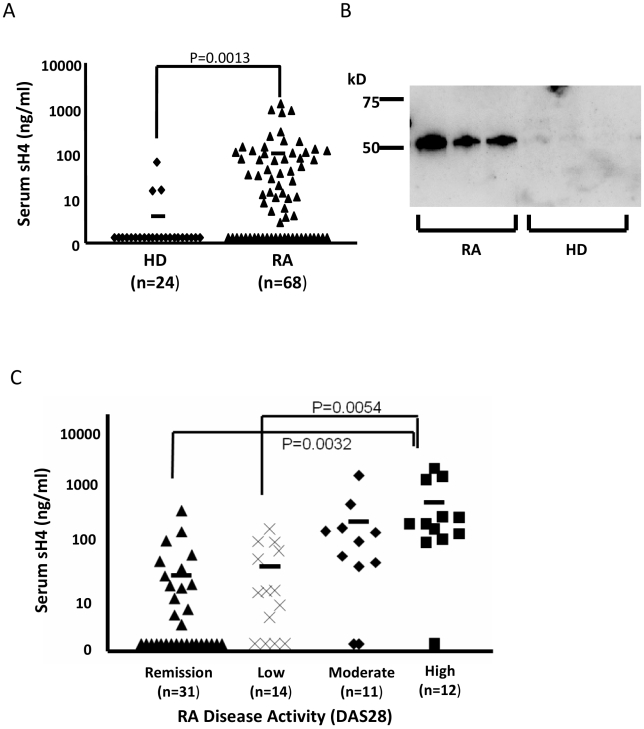
Detection of sH4 in sera from RA patients.(A) The concentration of the sH4 in HDs and in the patients diagnosed with RA. Sera from 68 RA patients and 24 HDs were diluted 1∶10 in PBS and tested by ELISA as described in Materials and Methods. The data were analyzed by the Mann-Whitney U test followed by a multiple regression analysis (p<0.01). (B) The sH4 in sera of RA patients was detected by Western blotting using HRP-labeled anti-human B7-H4 mAb (clone hH4.3). A 50 kDa sH4 band was detected in the sera of three patients with RA but not in the sera from three HDs. (C) The correlation of serum sH4 levels and disease severity in the patients with RA. Patients with RA were classified into four severity groups based on DAS28 score described in the Materials and Methods. The concentration of sH4 in the serum of each patient was determined by ELISA as described above. Statistical analysis was performed by ANOVA method followed by the Scheffé test. The bars represent the mean concentration of sH4 in all donors of each group (ng/ml).